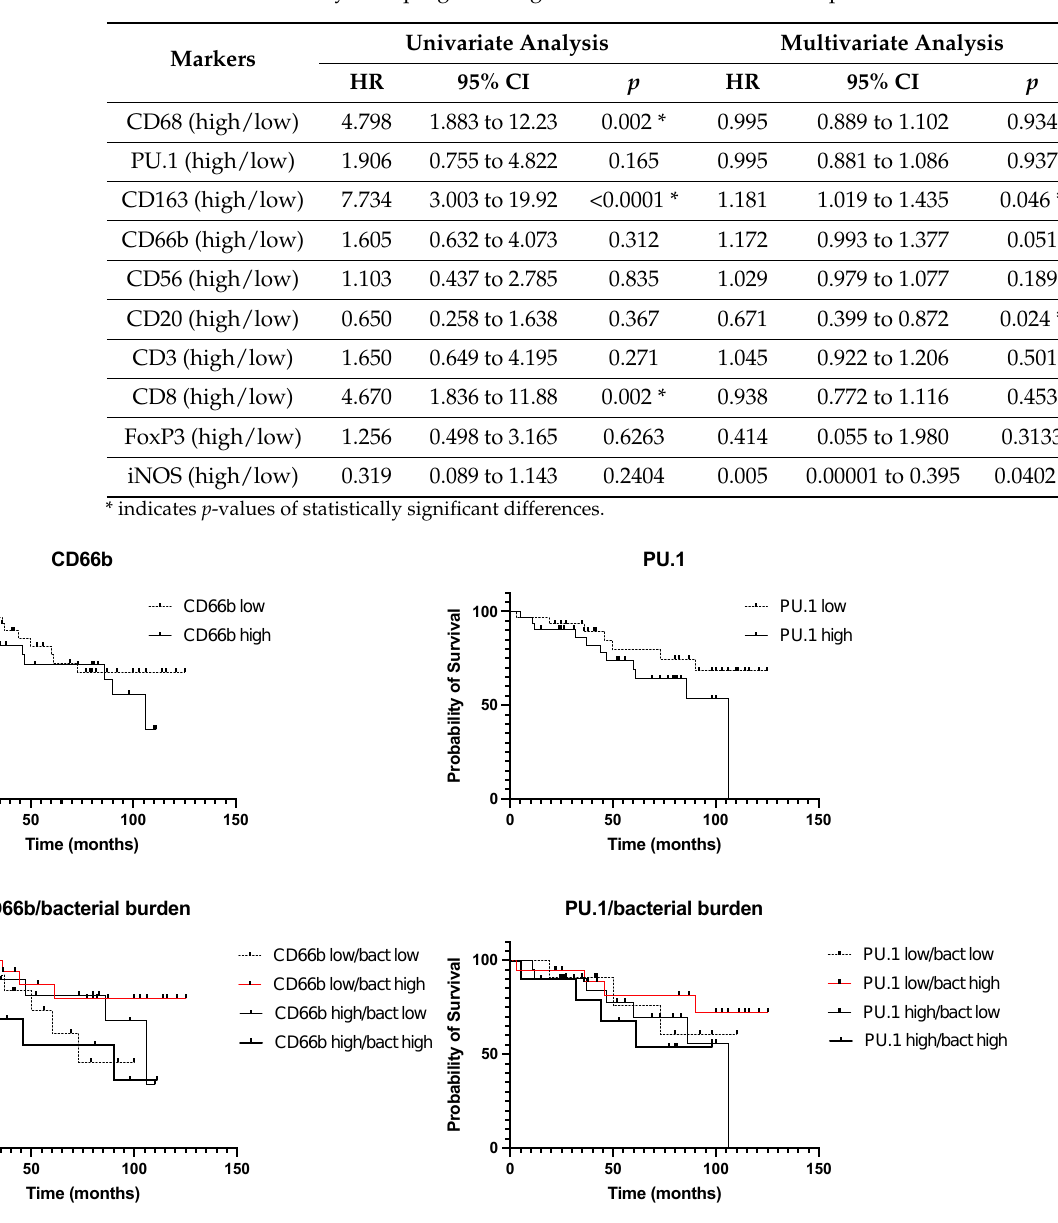
Table 6. Statistical analysis of prognostic significance stromal markers in patients with RCC.